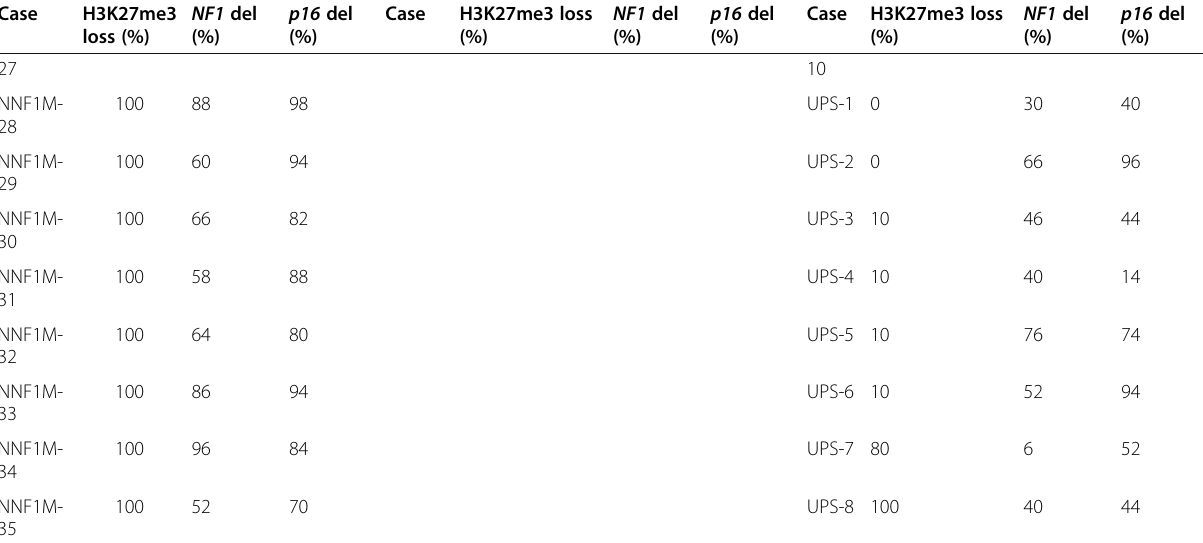
Table 1 Status of H3K27me3 loss, NF1 deletion, and p16 deletion in individual cases of MPNST and non-MPNST (Continued)